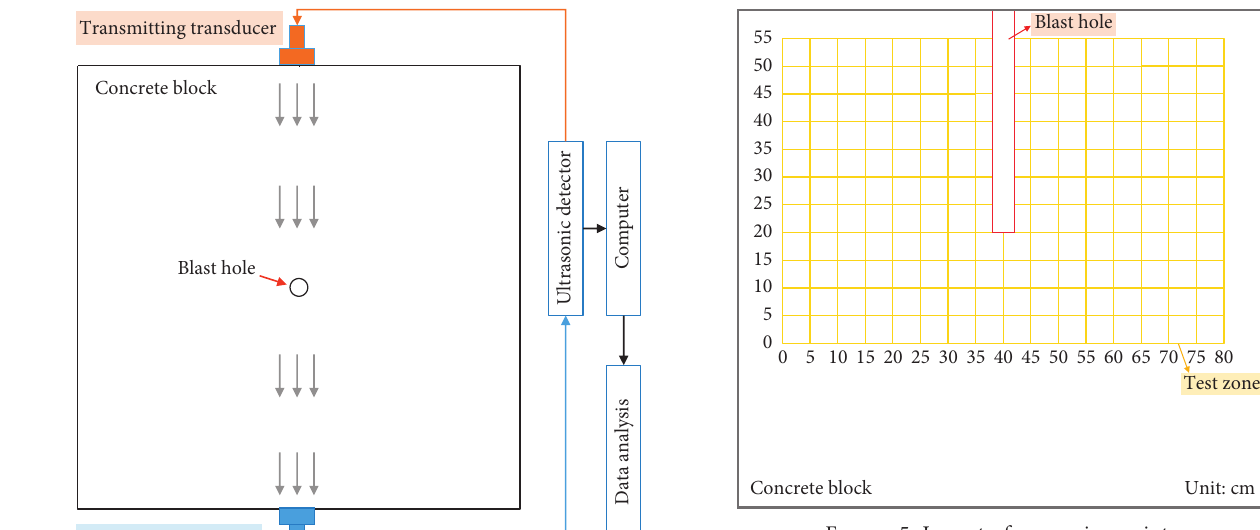
Figure 5: Layout of measuring